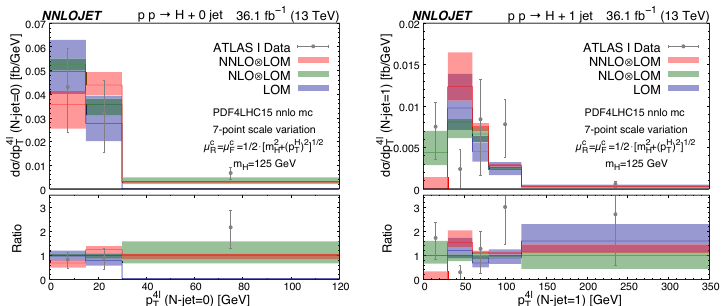
Figure 9. Transverse momentum distributions of the Higgs boson produced in association with zero (left) and one (right) jet for ATLAS I cuts and integrated